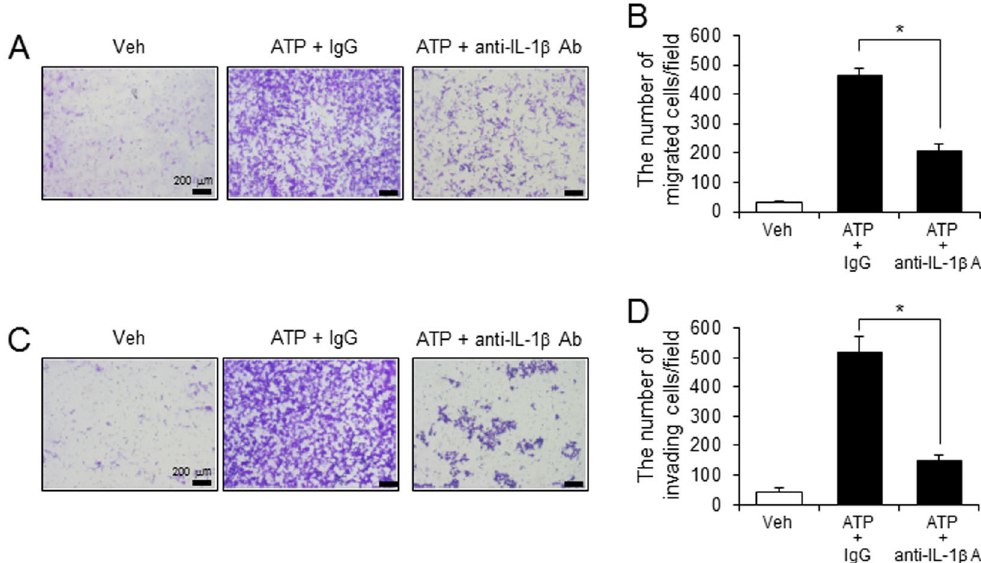
Figure 4. Tumor-promoting activity of macrophages is mediated through IL-1 β . Primary mouse macrophages primed by LPS (100 ng/ml) were stimulated with ATP (5 mM) for 1 hr in the presence of isotype control IgG or anti-IL-1 β antibody (10 μ g/ml). Conditioned culture supernatants were collected and added to the bottom chambers of transwells which had B16F10 cells plated in the upper chamber. After 24 hr, cell migration and invasion were determined. ( A ) Images of B16F10 cell migration. ( B ) The number of migrating B16F10 cells was counted in the microscopic field. ( C ) Images of B16F10 cell invasion. ( D ) The number of invading B16F10 cells was counted in the microscopic field. Values are means ± SEM (n = 5). * p < 0.05.